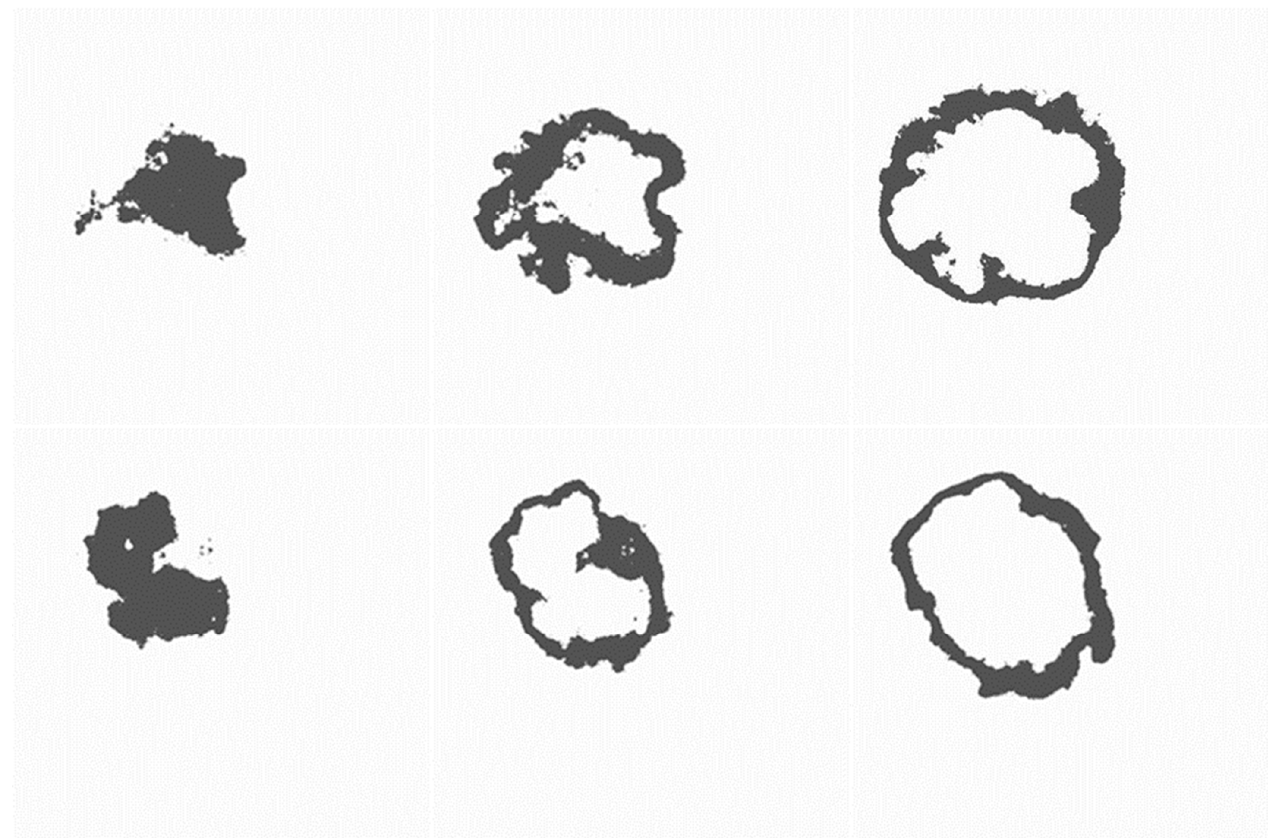
Figure 9. Projections of the intervals of conditional heights.